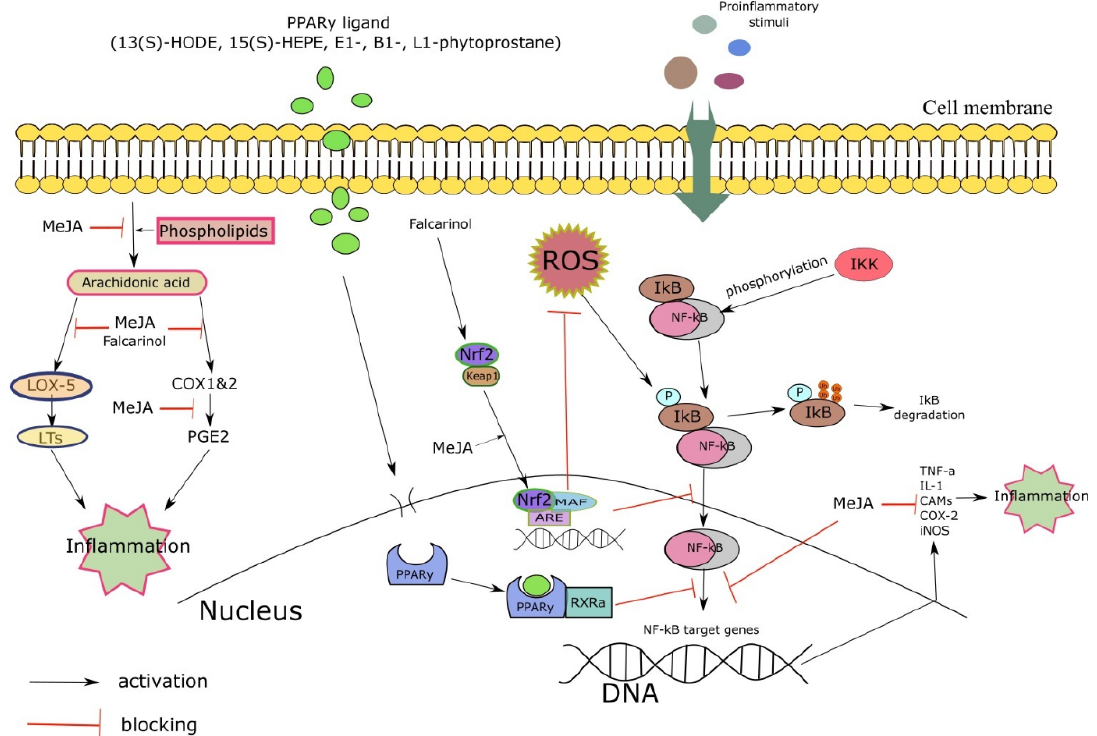
Figure 7. Schematic representation of the molecular mechanisms underlying the ability of plant oxylipins to exhibit anti-inflammatory and antioxidant activity. The internal or external proinflam- matory ligands activate several intracellular pathways leading to the synthesis of proinflammatory cytokines. Plant oxylipins can affect inflammation by activating nuclear factors (NF-kB, Nrf2, PPAR) or suppressing ROS formation and COX/LOX activity.